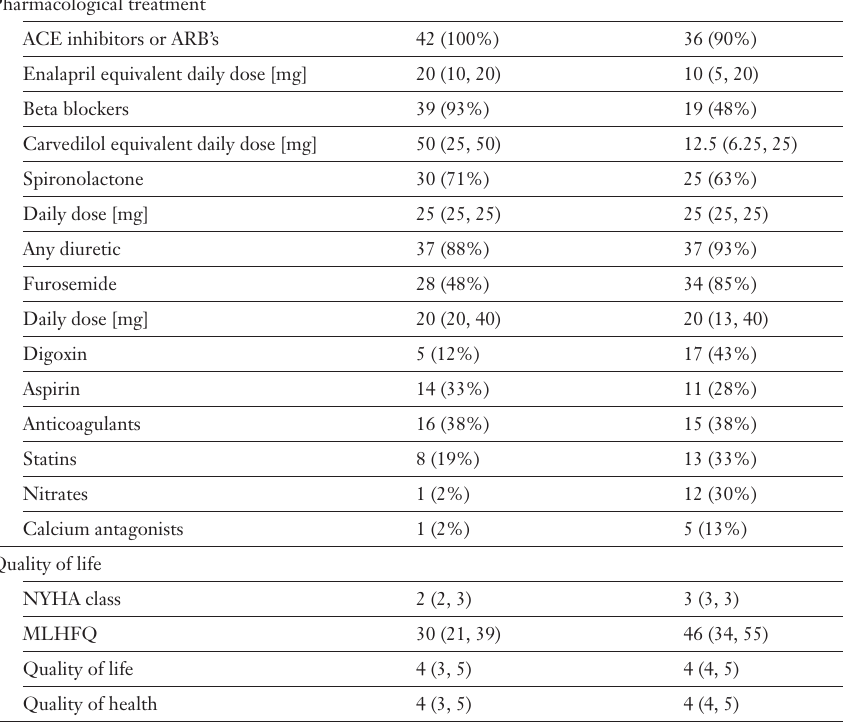
Table 3 Pharmacological treatment and quality of life at the end of follow-up. Data are presented as number of patients (%) and median (25 th and 75 th percentile).